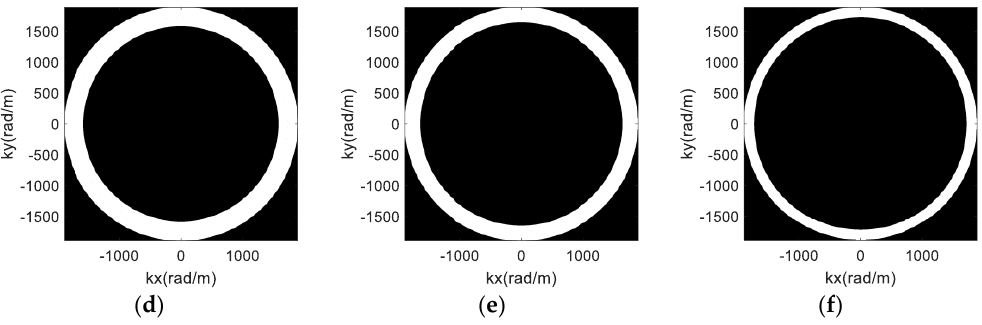
Figure 5. The spectral support of two antennas: ( a ) Type I; ( b ) Type II; ( c ) Type III; ( d ) Type IV; ( e ) Type V; ( f ) Type VI.